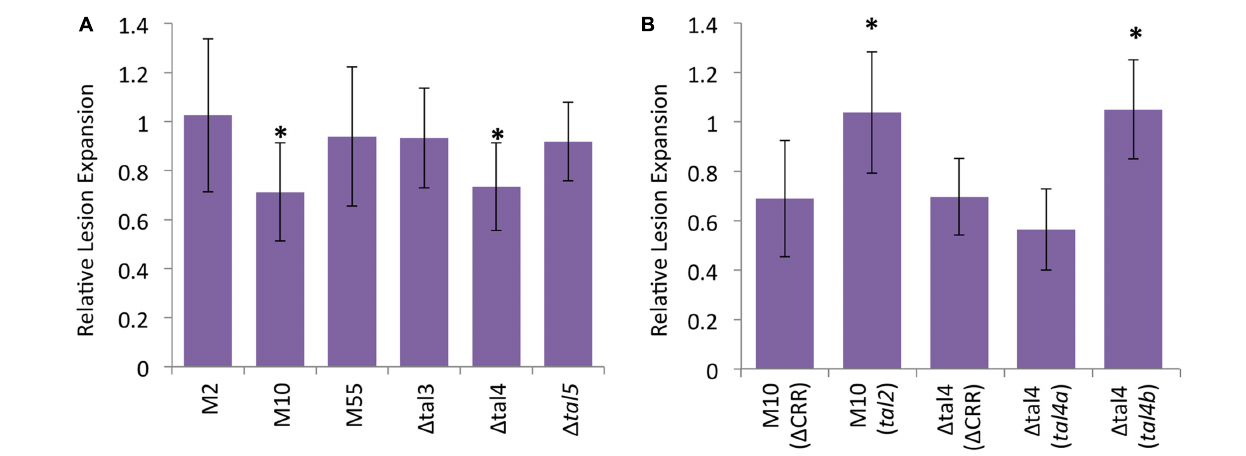
FIGURE 6 | Contributions of X. translucens pv. undulosa strain ICMP11055 Tal2 and Tal4b to virulence. (A) Lengths of lesions caused by tal gene knockout or deletion mutant strains relative to the wild type, inoculated side-by-side to leaves of 3-week old Triticum aestivum cv. Chinese Spring plants. Mutant strains include tal1 knockout M2, tal2 knockout M10, tal3a knockout M55, tal3a and tal3b deletion mutant (cid:49) tal3, tal4a and tal4b deletion mutant (cid:49) tal4, and tal5 deletion mutant (cid:49) tal5 . Values represent relative expansion of lesions beyond the inoculated area measured 9 days after inoculation (see Supplementary Figure S7 for images of representative leaves). At least twelve, paired inoculations were measured for each strain. An asterisk indicates a significant difference ( p < 0.01) from the wild type lesion measurement. Error bars represent standard deviation. (B) Genetic complementation of M10 by a plasmid-borne, dTALE equivalent of tal2 and of (cid:49) tal4 by a tal4b clone but not a tal4a clone (see Materials and Methods and Supplementary Table S1); (cid:49) CRR, control construct lacking the CRR (Supplementary Table S1). Assays were carried out as in (A) , and values relative to the wild type are presented, but here an asterisk indicates a significant difference from the relative value for the corresponding mutant transformed with the control construct. The experiments in (A,B) were repeated at least twice and yielded similar results in each